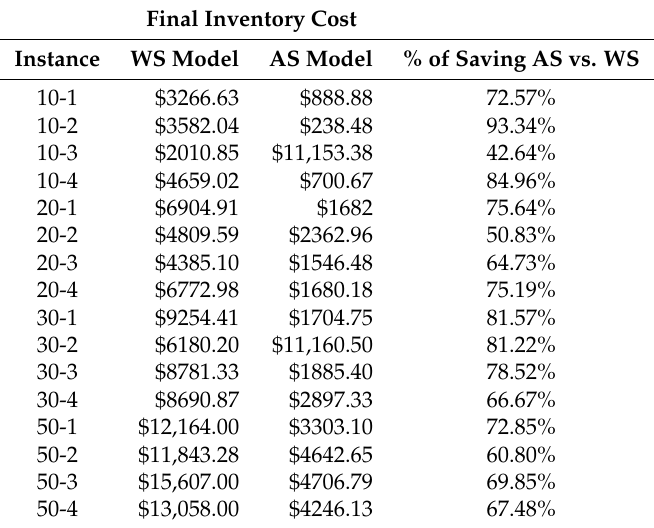
Table 9. Comparison of the final inventory cost for the AS model and the WS